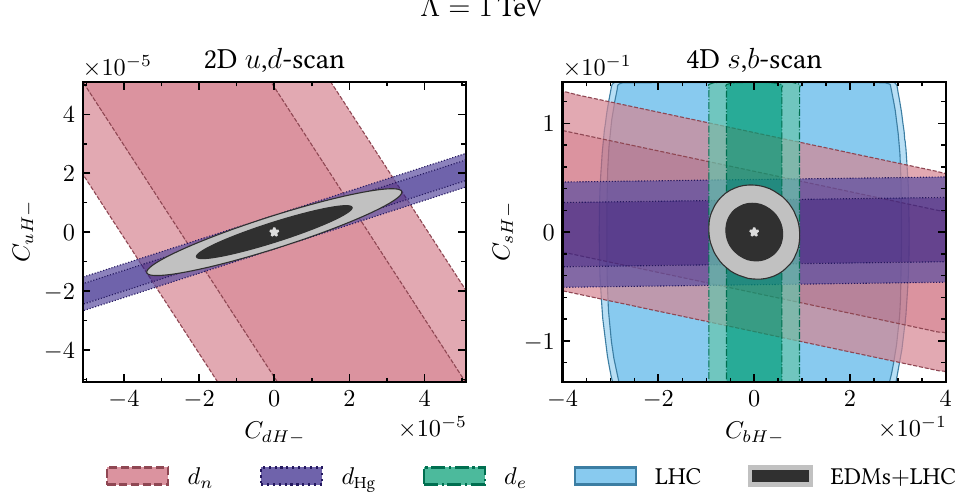
Figure 6 . Left : constraints resulting from the combined 2D scan of CP-odd up and down Yukawas ( C uH − , C dH − ). As the EDMs are not sensitive to the CP-even parts and the corresponding LHC constraints are weak we do not scan over those parameters. Right : constraints resulting from the combined 4D scan of CP-even and CP-odd bottom and strange Yukawas ( C bH ± , C sH ± ). Contours represent the allowed 68% and 95% confidence regions, the colour coding of individual constraints is given in the legend, and grey/black areas correspond to the combined regions. For more details see caption of figure